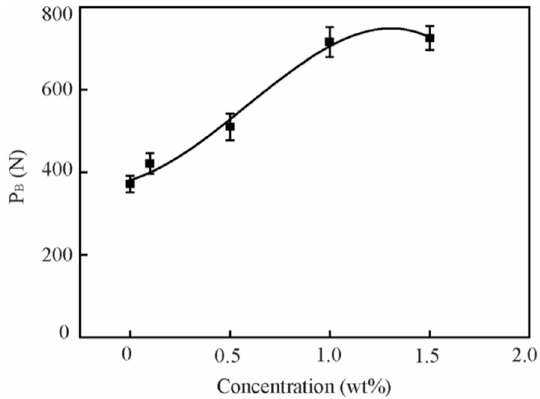
Figure 11. Maximum nonseizure load of the base oil and that with different concentrations of ZrS 2 additives.